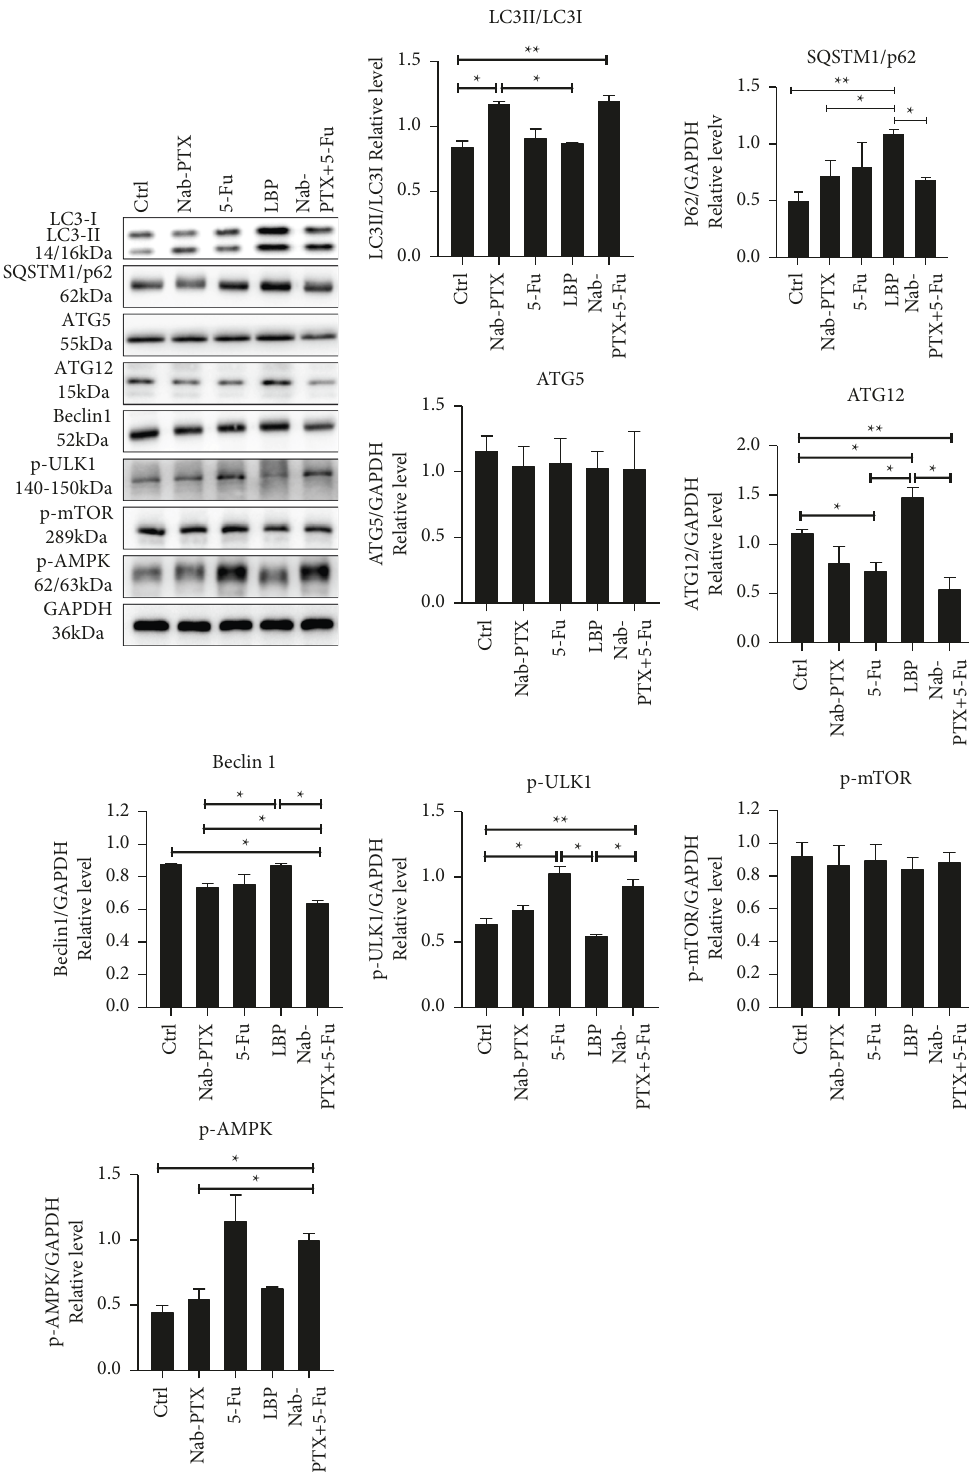
Figure 4: The effect of each group on autophagy of AGS cell line. Treatment of gastric cancer cells with Nab-PTX (0.2 μ mol/l), 5-Fu (2 μ mol/ l), LBP (10 μ mol/l), and Nab-PTX+5-Fu (0.2 μ mol/l+2 μ mol/l) for 24 hours; after protein extraction, WB experiment was performed. WB results showed the protein expression of LC3II/LC3I, P62, Beclin-1, Atg12, Atg5, p-mULK1, and p-AMPK. All the above experiments were repeated at least three times independently. ∗ P < 0 . 05, ∗∗ P < 0 .